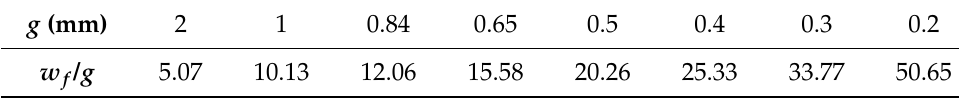
Table 4. The feed line width ( w f ) versus the inset gap width ( g